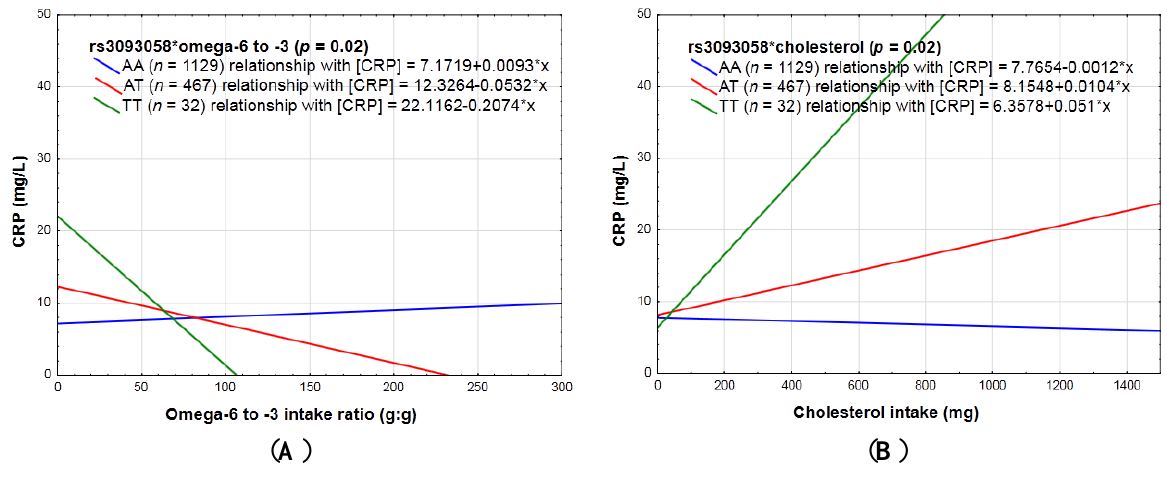
Figure 6. The linear relationship between ( A ) omega-6 to -3 ratio and ( B ) cholesterol in relation to CRP concentrations categorized for